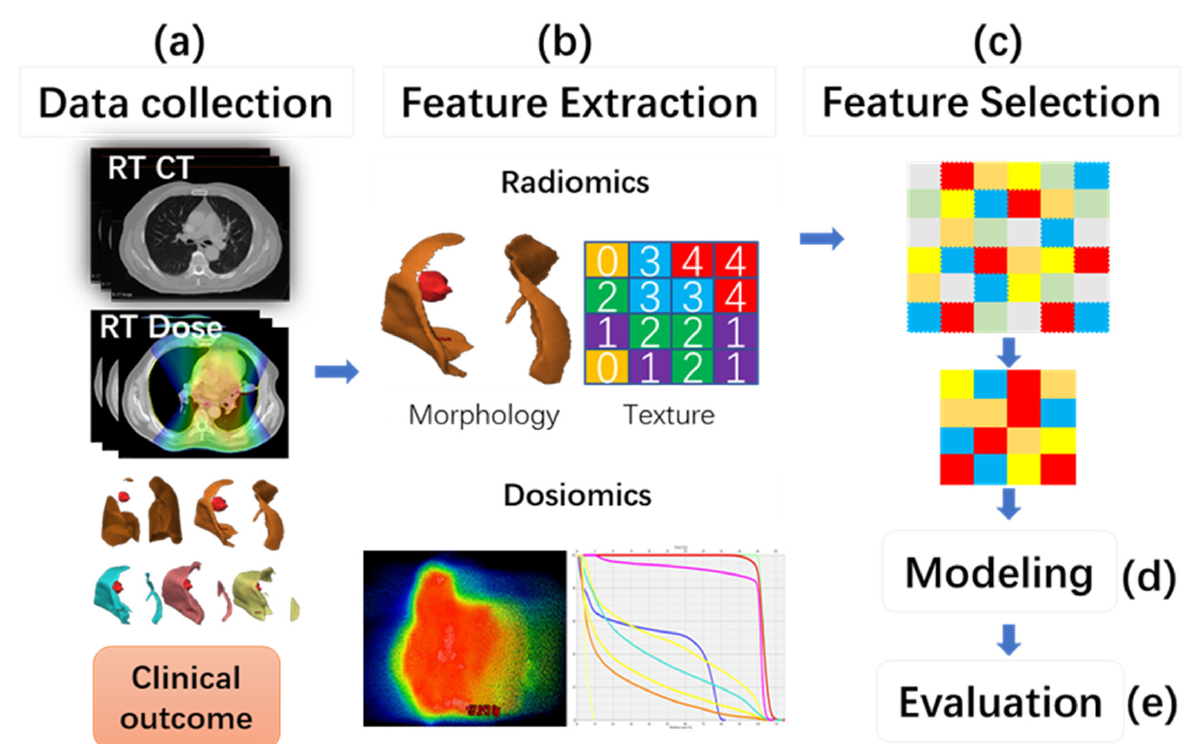
Figure 1. The overall workflow of the model construction. ( a ) collection of the clinical records and RT data, including pre-treatment CT images, planning dose distributions, and lung contours; ( b ) extraction of radiomics features (RF) and dosiomics features (DF), including DVH parameters using the planning CT image and RT dose distribution; ( c ) feature selection; ( d ) model construction; ( e ) model performance